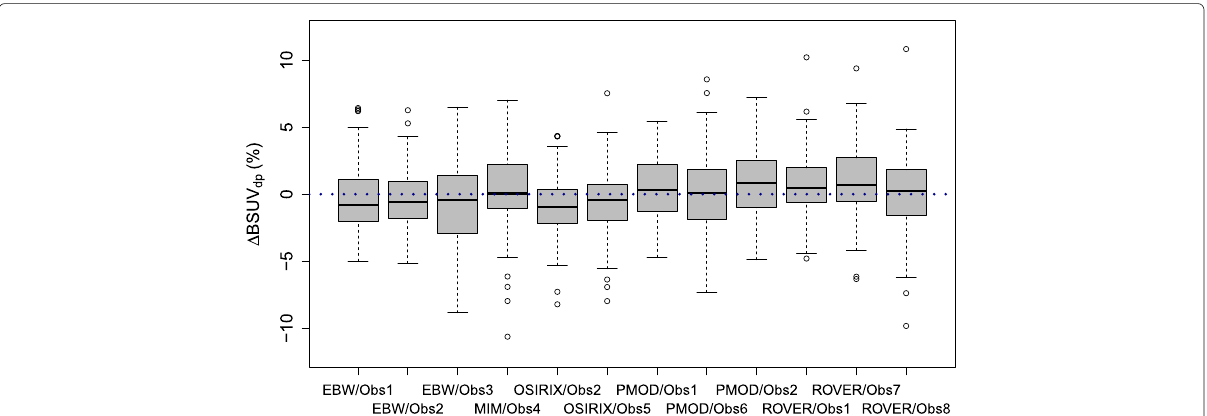
Fig. 5 Boxplot of fractional deviation from observer mean for the respective patient ( (cid:2) BSUV dp ), grouped by observer. Note the comparable performance of all observers